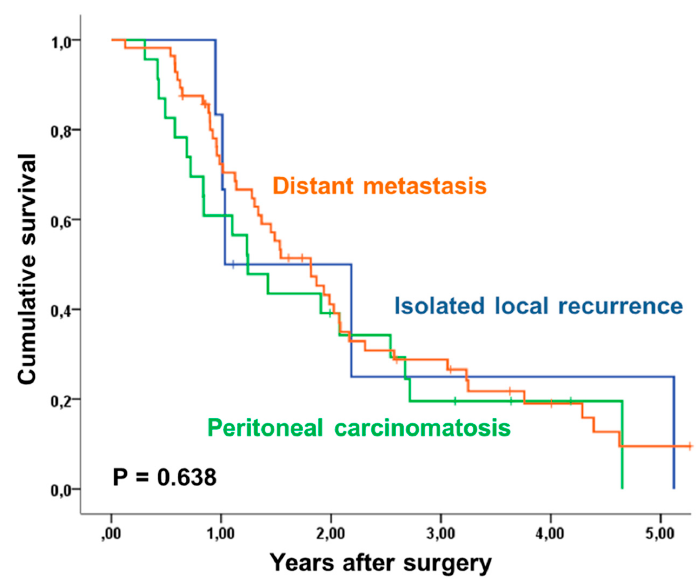
Figure 2. Overall Survival in 82 patients with recurrence after FLOT and surgical resection of esophagogastric adenocarcinoma: influence of recurrence site. Patients with isolated local recurrence ( n = 6) versus distant metastasis ( n = 53) versus peritoneal carcinomatosis ( n = 23) expect a similar survival.